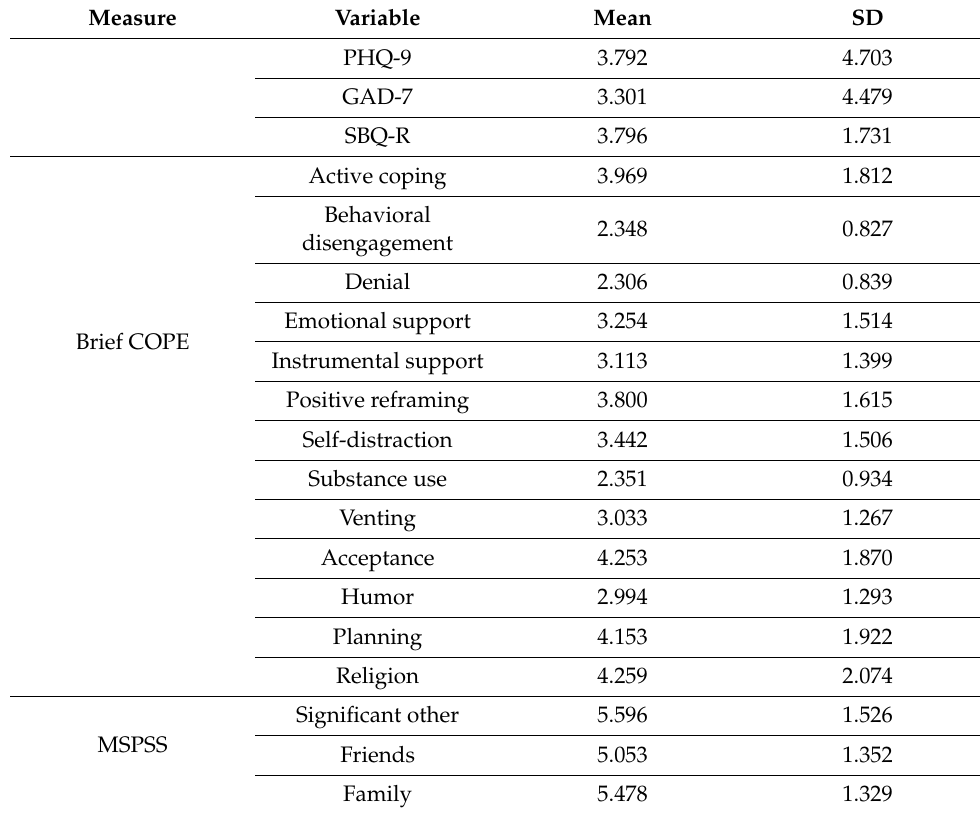
Table 2. Mean and standard deviation for PHQ-9, GAD-7, SBQ-R, Brief COPE, and MSPSS.